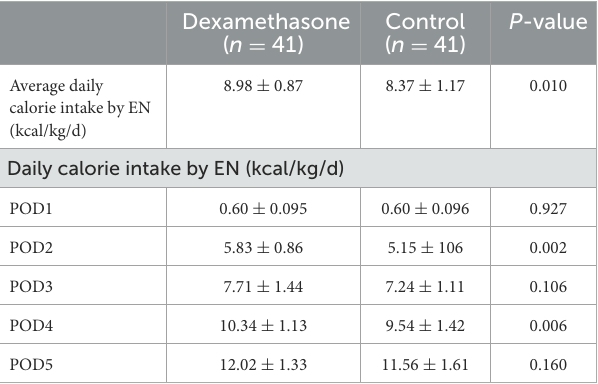
TABLE 3 Enteral nutrition caloric intake in enterotomy surgery group.